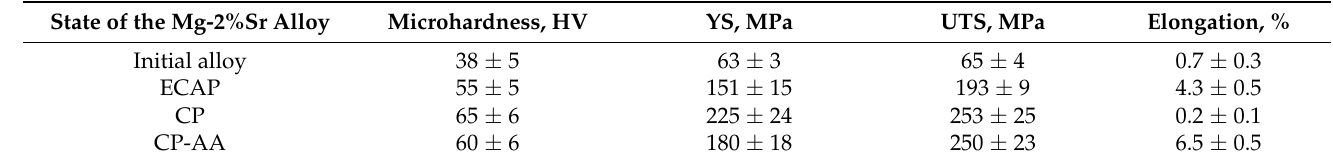
Table 2. Mechanical properties of the Mg-2%Sr alloy after different treatments.